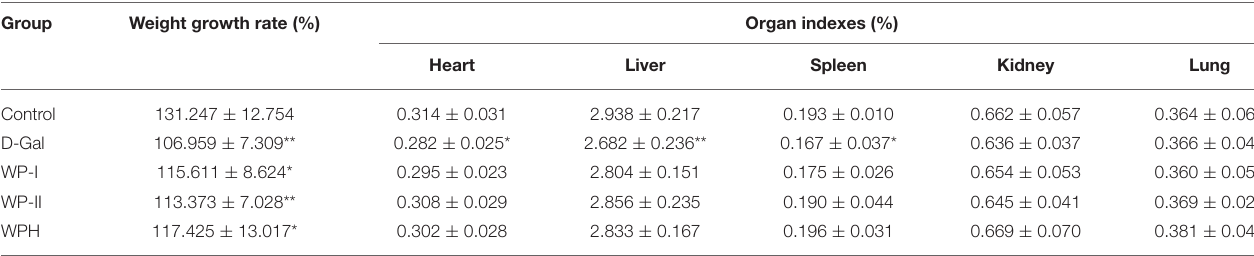
Control represents the normal control group (saline); D-Gal represents the model control group (D-galactose); WP-I and WP-II represents the low dosage and high dosage of walnut protein group, respectively; WPH represents the walnut protein hydrolysate group. * Significant differences (p < 0.05) and ** significant differences (p < 0.01) vs. the control group,